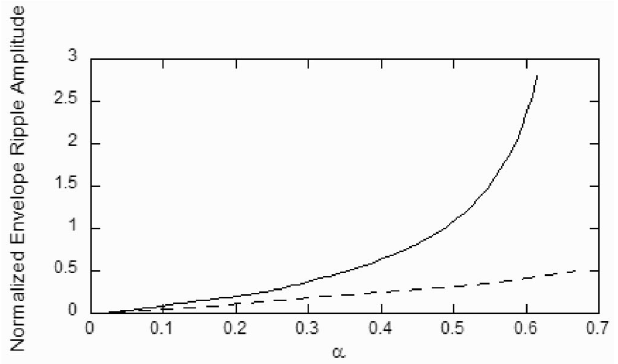
FIG. 9. Increase in normalized emittance (solid line) and cur- rent (dashed line) to maintain balanced flow for the emittance and space-charge dominated cases, respectively, as the wiggler period is increased.